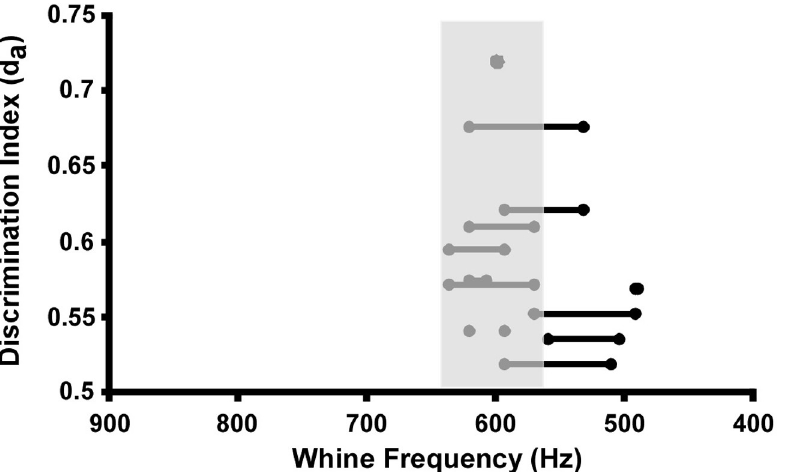
Fig 11. Whine fundamental frequencies eliciting highest discrimination of whine versus noise when calculated using different bin widths. Symbols (also connected by lines) show the d a for bins with maximum sensitivity when plotted on the x-axis not as bin width (time), but as whine frequency. The 1 ms bin width yielded the highest d a at 601 Hz. Grey area represents the transition frequencies important to whine recognition, which were predicted by Wilczynski et el. [30] from behavioral data.